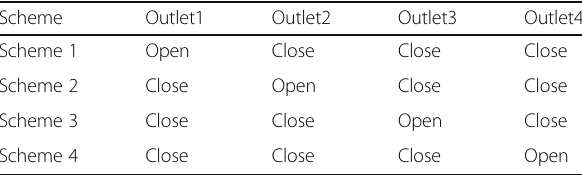
Table 1 Manifold air flow